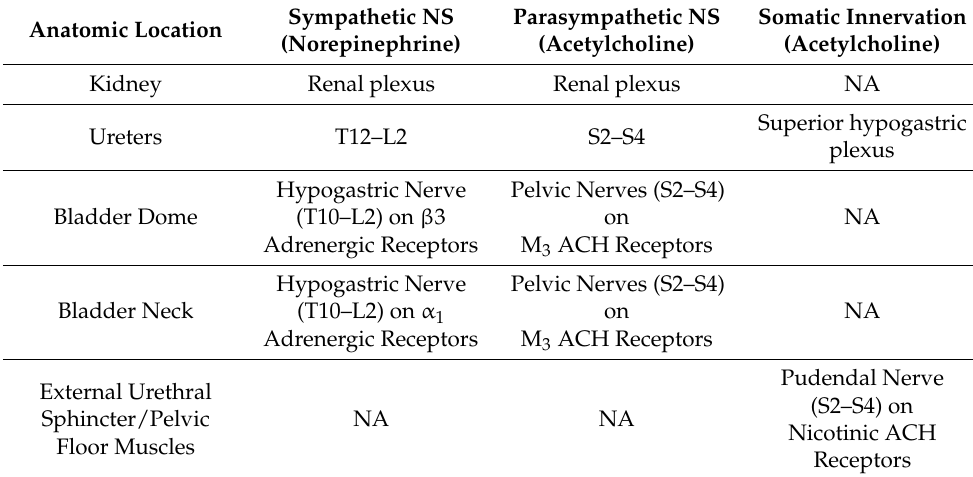
Table 1. Innervation of the urinary